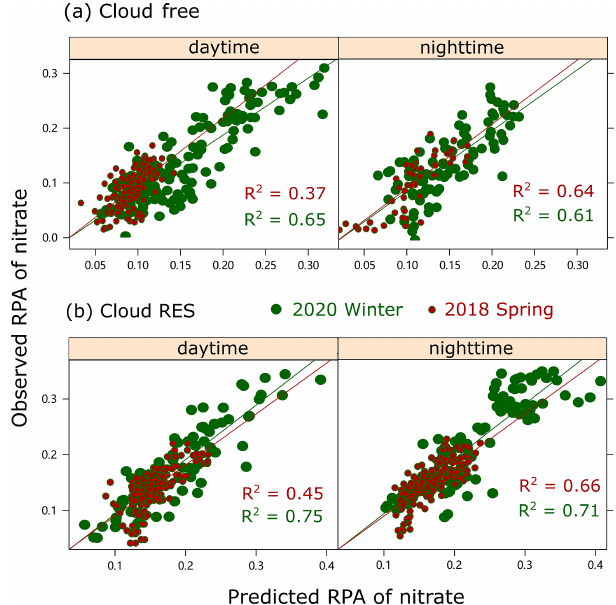
Figure 4. Correlation analysis between the observed RPAs of ni- trate and the predicted RPAs of nitrate, with inputs of NO 2 , O 3 and LWC, for the (a) cloud-free and (b) cloud RES particles, respec-